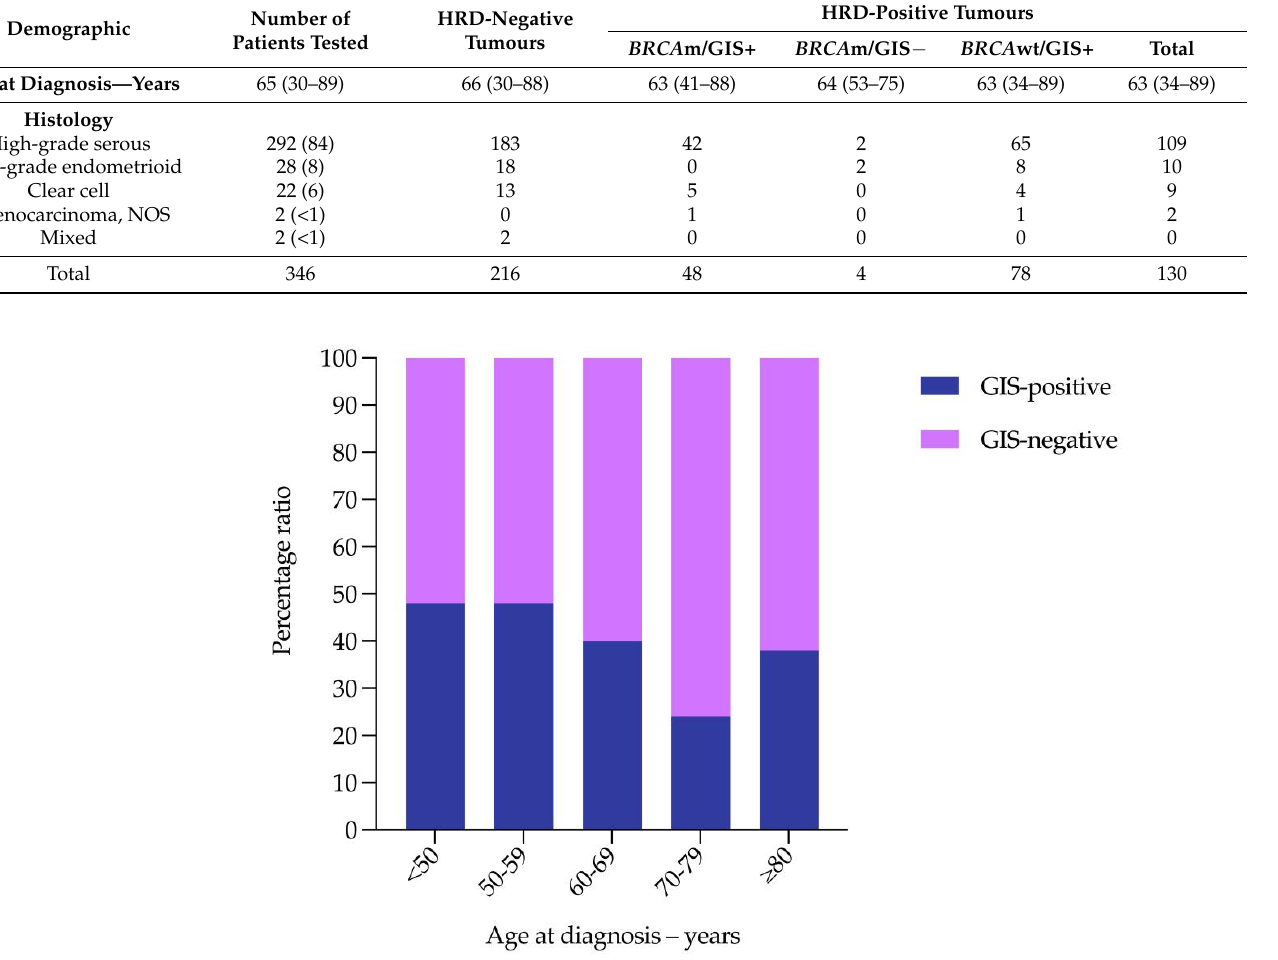
Figure 2. Percentage ratio of GIS-positive versus GIS-negative tumours according to age group. Table 4. Genomic instability score status categorized by age group. Data are presented as number (percentage; the denominator is the ‘Number of patients tested’ in each age group). Key: BRCA m, BRCA1/2 pathogenic variant; BRCA wt, BRCA1/2 wild type.